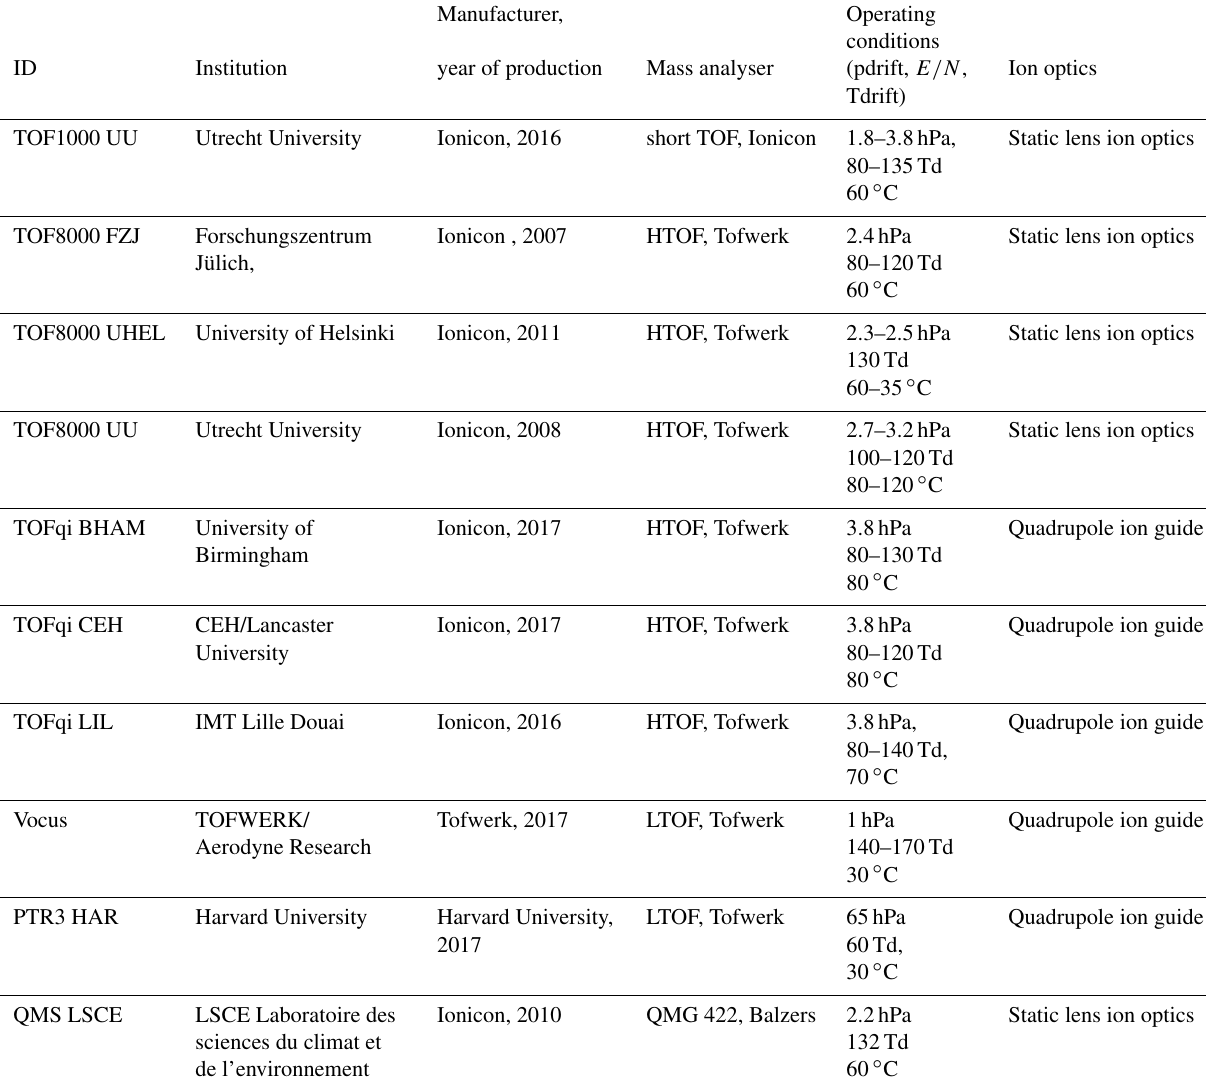
Table 1. Overview of the PTR-MS instruments participating in the inter-calibration